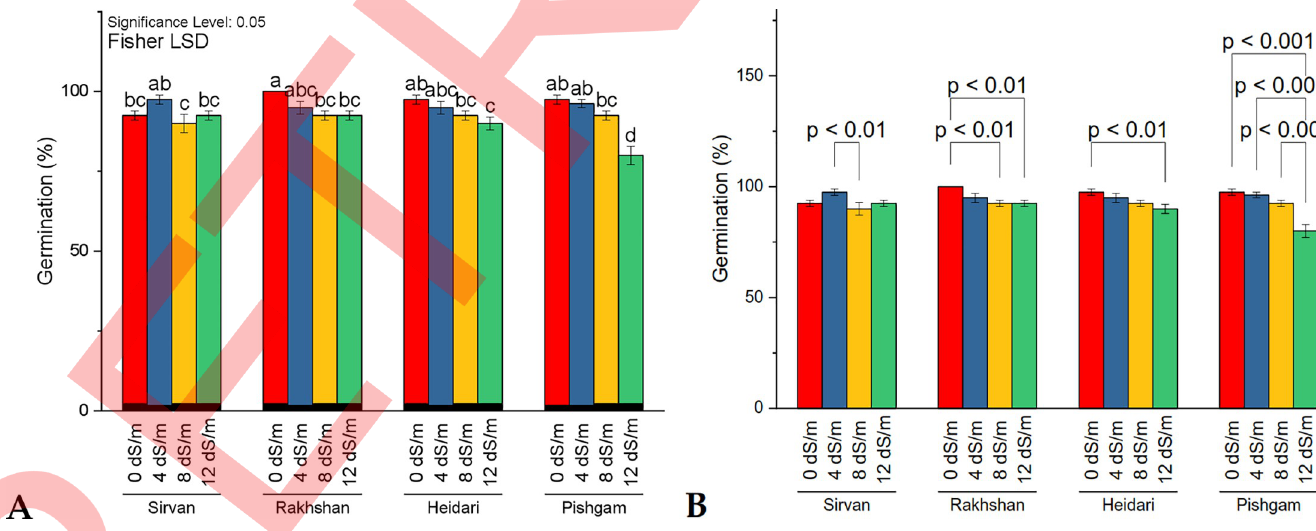
Fig 1. Effects of salinity on germination percentage in wheat varieties. A) Means are average of four replicates. Different values showed significant difference at p < 0.05 compared by LSD. B) Different values at bars are p values obtained during LSD comparison of wheat varieties and salinity levels.